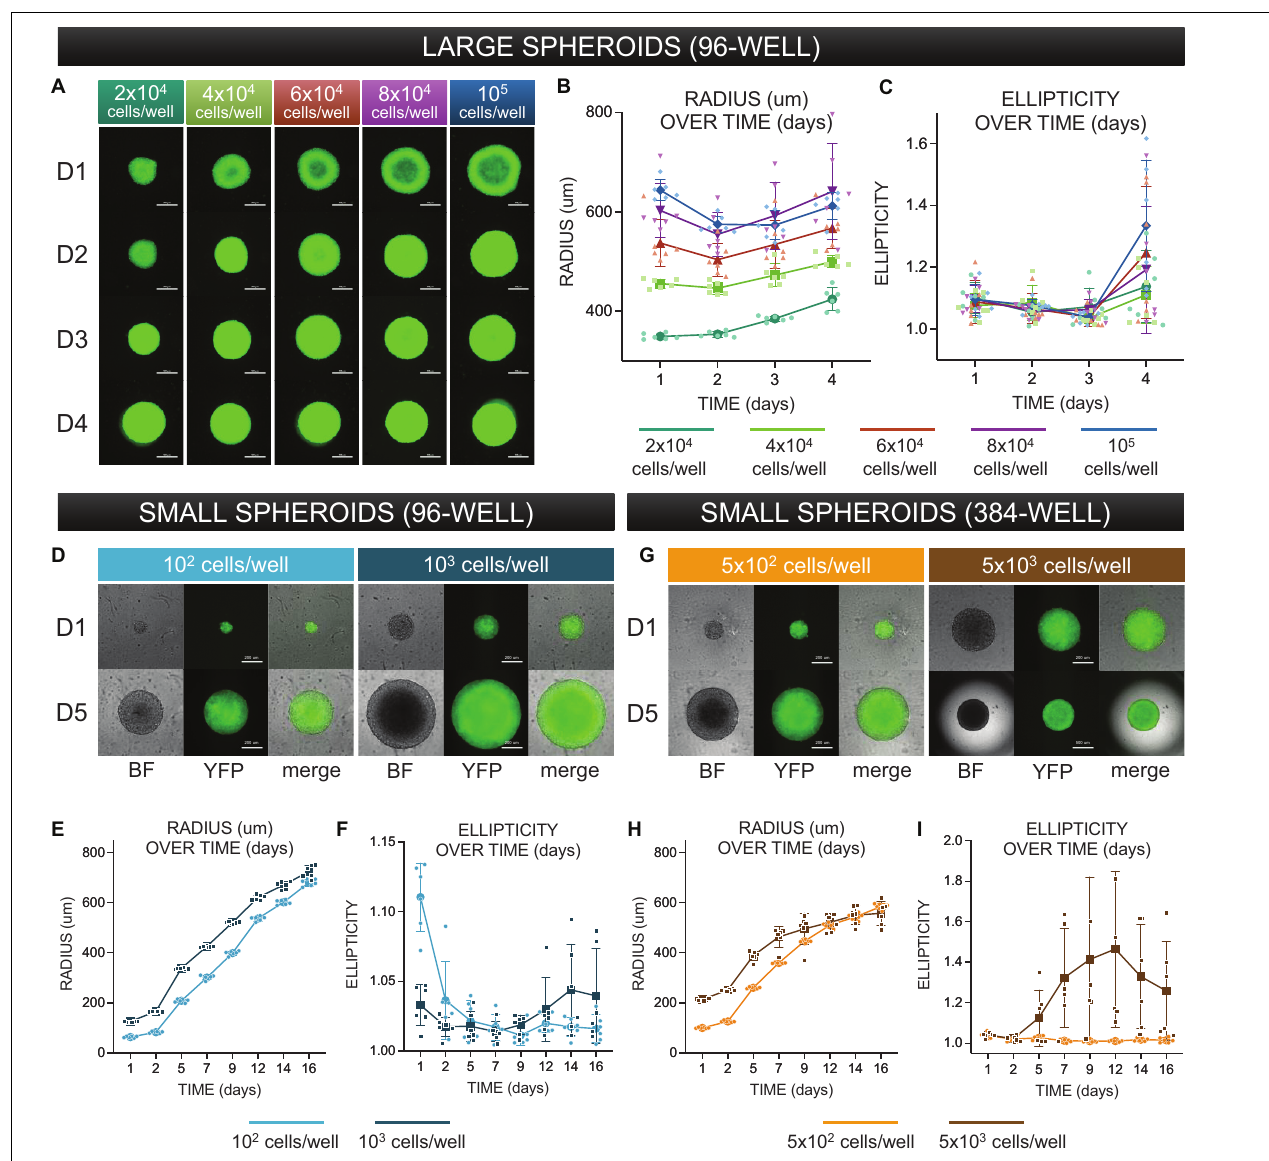
FIGURE 3 | Morphological characterization of three-dimensional spheroids as function of cell density. (A) Assembled “large” spheroid constructs initially seeded at (G1) 2 × 10 4 cells/well, (G2) 4 × 10 4 cells/well, (G3) 6 × 10 4 cells/well, (G4) 8 × 10 4 cells/well, and (G5) 10 × 10 4 cells/well. Both brightfield images and fluorescence images (to confirm expression of ChR2-eYFP) were taken every 24 h over 4 days. Scale bar is 0.5 mm. (B) Standard imaging tools were used to contour a five-point ellipse to the outline of the imaged spheroid. Axes were then used to calculate average radius and ellipticity for each spheroid over 4 days. (C) Radius [(major axis + minor axis)/2] as a function of time. (D) Shape (major axis/minor axis) as a function of time. For (C–D) , the sample size is 30 spheroids, n = 6 per density and per time point. (D) Assembled “small” spheroids with initial seeding of 10 2 and 10 3 cells per well in a 96-well format – brightfield and eYFP fluorescence images shown at days 1 and 5. Scale bar is 0.2 mm. (E,F) Radius and ellipticity over 16 days. The sample size was 12 spheroids, n = 6 per density and per time point. (G) Assembled “small” spheroids with initial seeding of 5 × 10 2 and 5 × 10 3 cells per well in a 384-well format – brightfield and eYFP fluorescence images shown at days 1 and 5. (H,I) Radius and ellipticity over 16 days. The sample size was 12 spheroids, n = 6 per density and per time point. Scale bar is 0.2 mm for day 1 and 0.5 for day 5. In panels (B,C,E,F,H,I) , all data points are overlaid in addition to the mean and standard deviation. See Supplementary Figures 1 – 4 for complete large spheroid, 96-well format dataset. See Supplementary Figure 7 for complete small spheroid, 96-well and 384-well format datasets. Please see text and Supplementary Figure 8 for details on statistics.